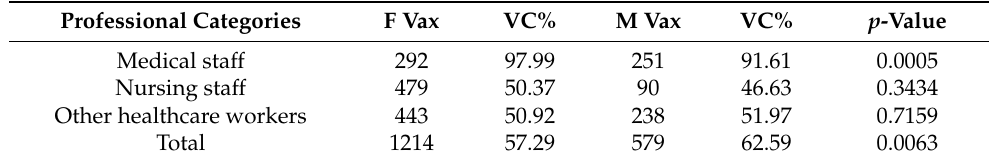
Table 8. Distribution by gender (F = females; M = males; Vax = vaccinated) of recorded vaccination coverage (VC%) among the different professional categories working at